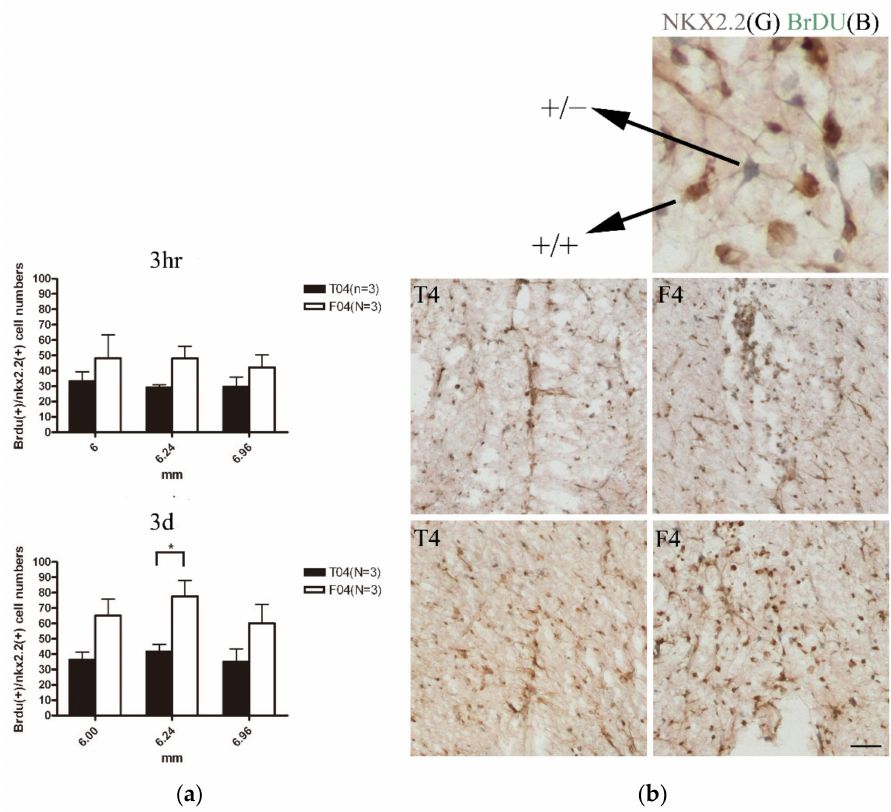
Figure 9. ( a ) Pairwise t -test. *: p < 0.05. Data are presented as mean ± SEM. Animal number used: T4 ( n = 3) F4 ( n = 3). ( b ) A cross-section near 6 mm from the trauma center showing the cells around the center cavity in the dorsal column. Nkx2.2 (+) was used to characterize OPC and pre-myelinating oligodendrocytes. For the short pulse, the rats were injected with BrdU 3 h before sacrifice. For the long pulse, the rats were injected with BrdU every day after operation and collected at 4 days post- operation. The sections were double stained with Nkx2.2 (grey) and BrdU (brown) with vectastain kit. Scale bar = 50 µ